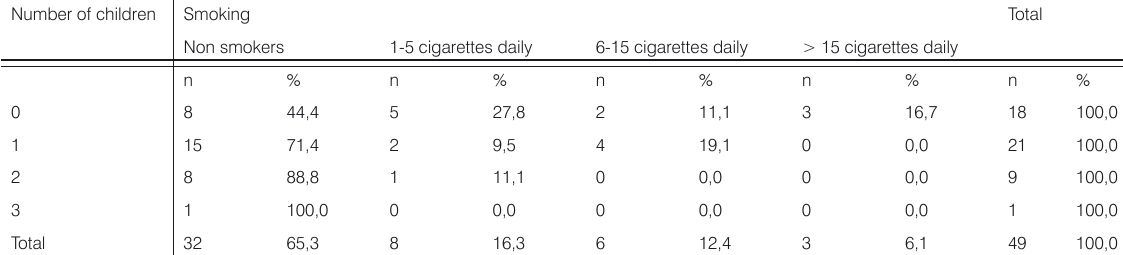
Table 4. Dependency between the number of children and smoking habit